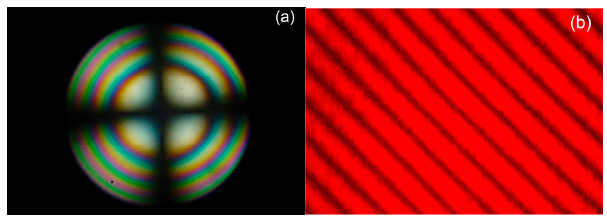
Figure 4. ( a ) Conoscopy and ( b ) birefringence fringe patterns for a Mg:CLN crystal.